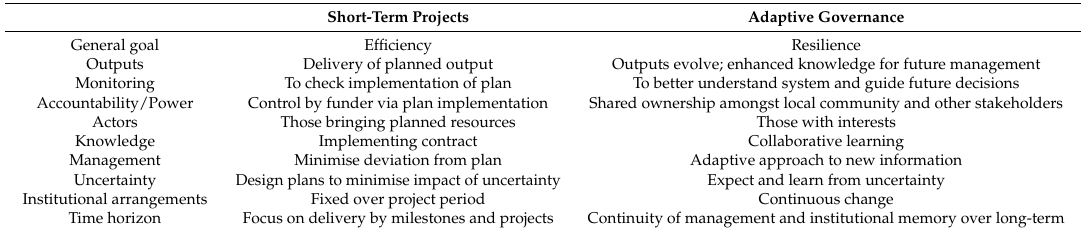
Table 1. Comparison of short-term projects and adaptive governance